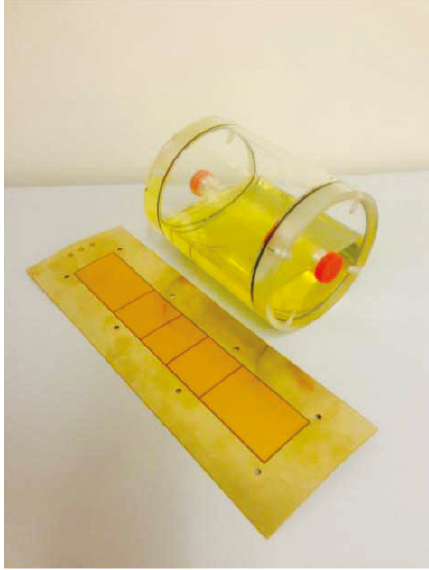
Figure 2: Propellant tank used in the experiments with sample